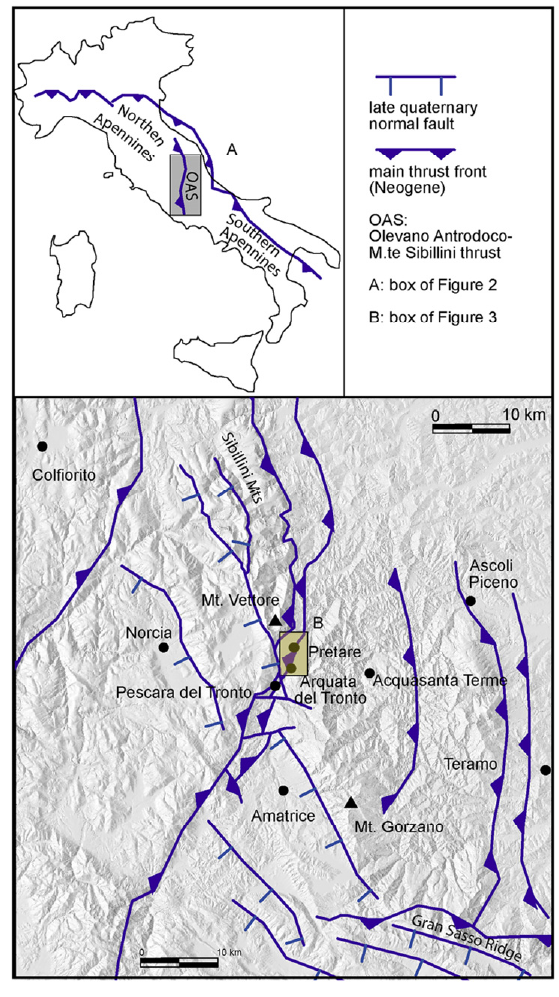
Figure 3. Structural sketch map of the axial zone of the Central-Northern Apennines chain showing the NE–SW-oriented normal fault segments and the main thrust lines. From a geomorphological point of view, the Pretare-Piedilama area is included in a narrow NNE-SSW-oriented catchment fluvial basin of about 12.5 km 2 in width. The from the Lower Pleistocene, a new geodynamic regime with a drainage basin shows an asymmetric drainage net with the main and most developed stream channels flowing from NW to SE on the right-side valley as tributaries of the Morricone-Pianella stream valley, forming a trellis-like pattern. The Morricone-Pianella stream is a left tributary of the Tronto River forming at its mouth a narrow and entrenched valley of about 1 km-length which was filled by several orders of unpaired fluvial terraces. The confluence of the Morricone-Pianella Stream in the Tronto River corresponds to a large local base level which represents the morphological threshold of the Pleistocene Amatrice intermontane basin [83]. The threshold of that basin is also suggested by two main morphological features. The first is a knickpoint occurring in the Tronto longitudinal channel profile and placed at about 580–600 m of elevation a.s.l., and the second is a strong change of channel flow direction in the Tronto River. These morphological features represent the morphological response of the Tronto river valley to the regional tectonic uplift which affected the whole Amatrice basin and surroundings, suggesting a steady state configuration in the upstream reach of the Tronto River [84]. Indeed, the fault system activity seems to have inhibited the backward fluvial wave incision which started in the palaeo Tronto River mouth ~450 ky because of the Middle Pleistocene uplift ([84] and references